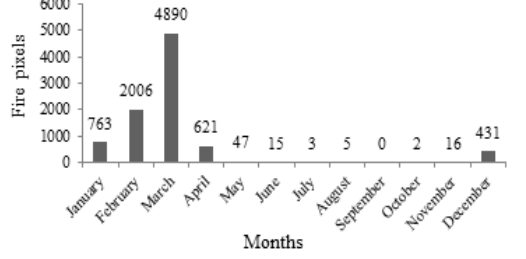
Fig. 2. Intra-annual trends of forest fires in Nagland (2001-2013).